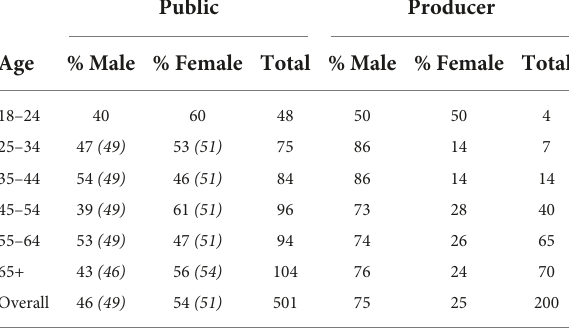
TABLE 3 Age/gender demographics of the public and red meat producer respondents (Census data in italics where available).